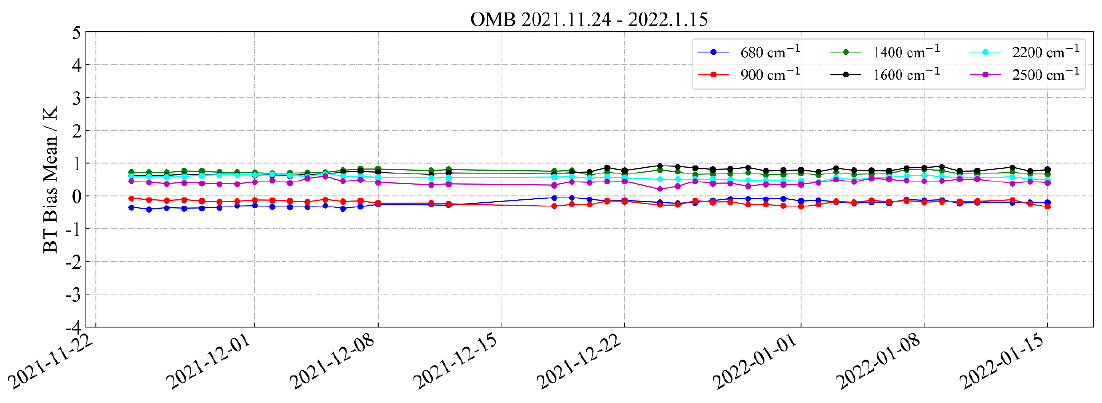
Figure 25. Distribution of the bias of OMB over time.